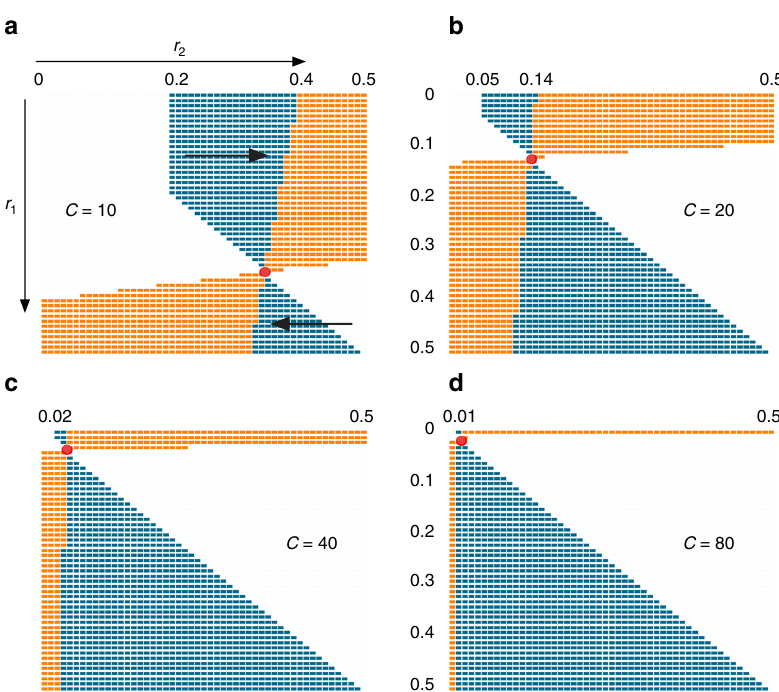
Fig. 2 Local stability analysis of the recombination rate r between the plasticity and the target locus under the genomic storage effect. For each pair of recombination rate alleles, r 1 and r 2 , the corresponding color indicates whether r 2 fi xes over r 1 (blue) or whether the two rates coexist at intermediate frequencies (orange), as predicted by the local stability analysis for C = 10 ( a ), 20 ( b ), 40 ( c ), and 80 ( d ). Empty cells imply that no plasticity – target polymorphism was present at equilibrium — i.e., no genomic storage possible. All the blue cells above the diagonal imply evolution toward higher recombination rates, while the blue cells below the diagonal imply evolution toward lower recombination rates (see arrows in the fi rst panel). For example, under C = 10 an allele encoding no recombination will perish when competed with any rate ranging from 0.2 to 0.39, but it will coexist in balanced polymorphism with the rates in the range 0.4 – 0.5. The red dot corresponds to the ES recombination